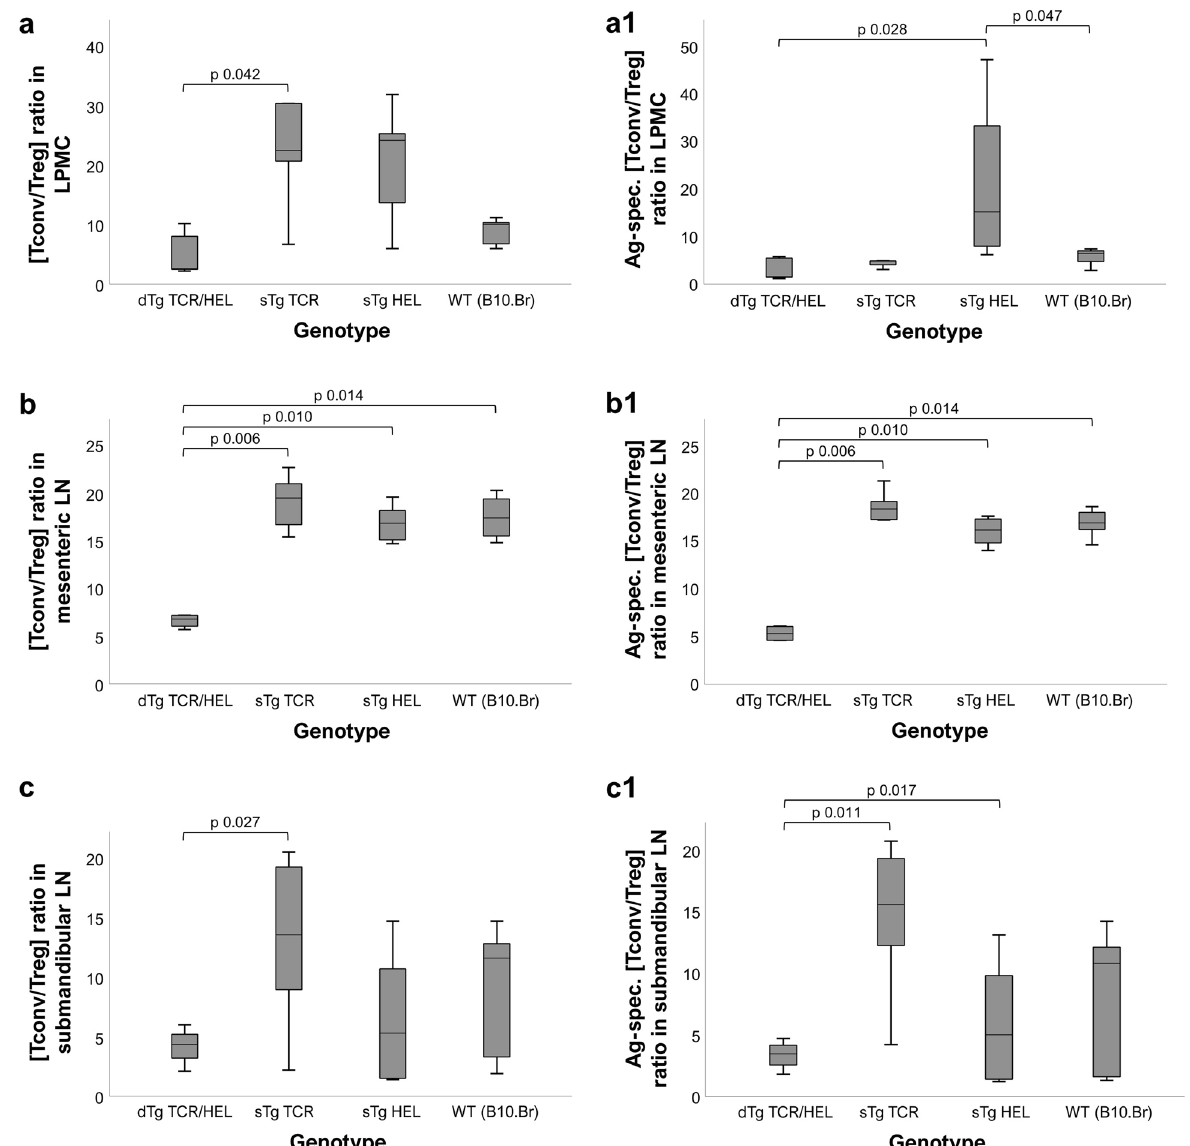
Figure 3. Mice with the dTg genotype have relatively lower (antigen-specific) [Tconv/Treg] cell ratios across different tissues. ( a , a1 ) in LPMC (lamina propria mononucleated cells); ( b , b1 ) in mesenteric lymph nodes (LN); and ( c , c1 ) in submandibular (eye-draining) LN. dTg mice were found to have significantly lower [Tconv/Treg] quotients across all tissues as compared to their non-lymphopenic counterparts. The same was true with reference to antigen-specificity. Treg cells had been defined as CD4+ CD25+ FoxP3+, Tconv as CD4+ CD25± FoxP3-. Antigen-specific populations had been classified as Vbeta8.1/8.2+ 17 . Ratios were calculated based on absolute cell numbers [n] acquired using flow cytometry. Non-parametric statistical procedures were used, significance taken as p ≤ 0.05. Per genotype group n = 5–7 mice (aged P30 ± 3) were used across 2–3 independent